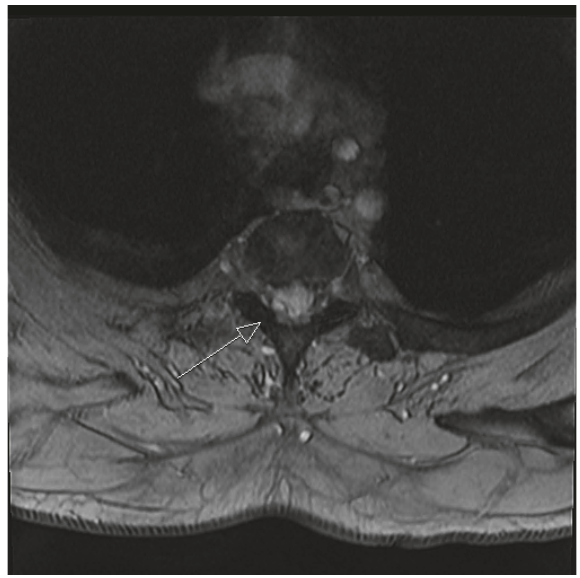
Figure 2: MRI of the upper spinal column T2-weighted sequence, transverse plane. White arrow indicating tumor location with compression of spinal